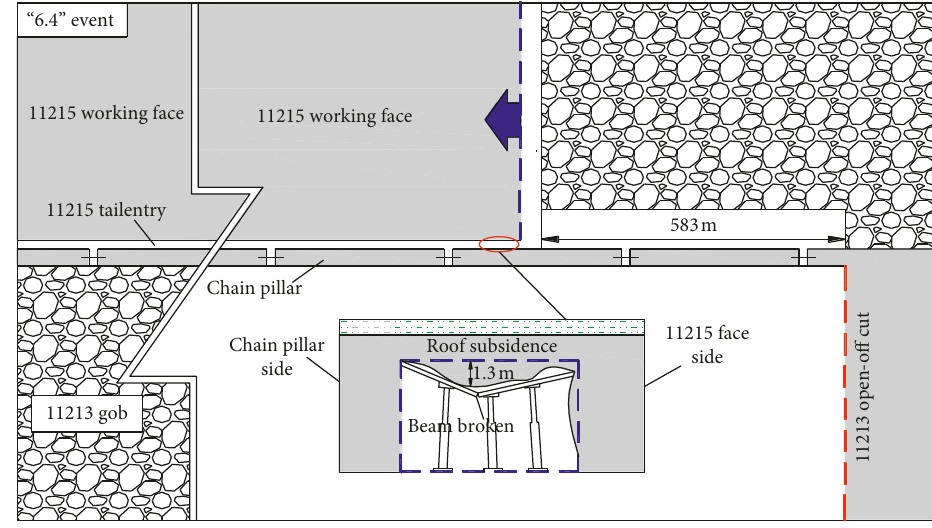
Figure 6: Sketch of the “6.4”